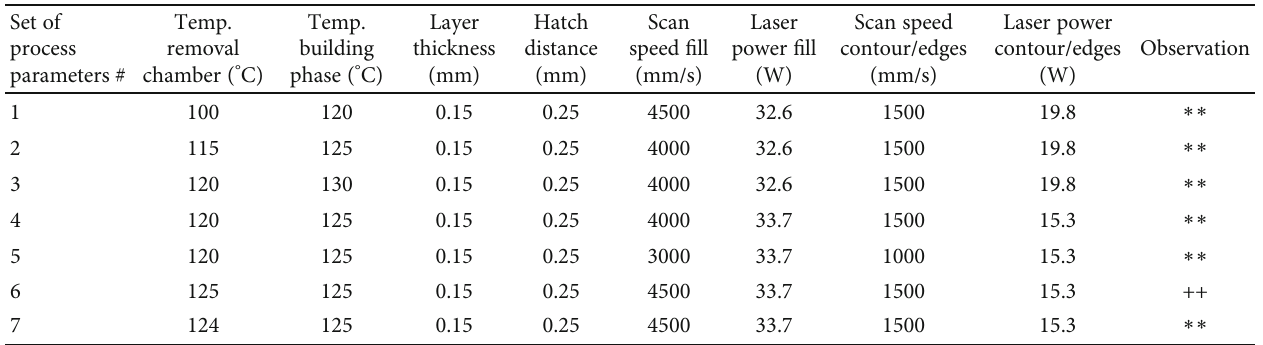
Table 5: Parameters and observations made while establishing optimal removal and building chamber temperature. Set of Temp. process parameters #